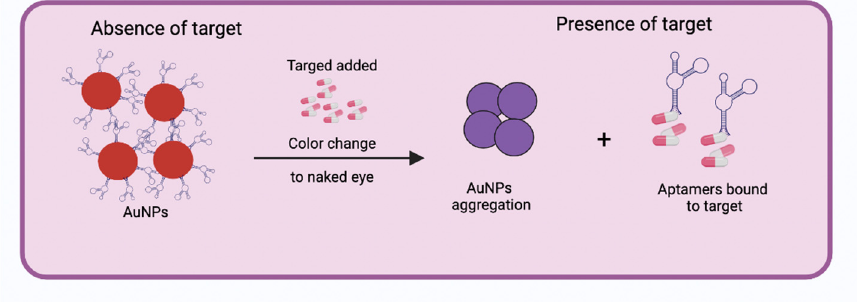
Figure 2. Schematic representation showing the operation of an aptasensor. The soil or water samples are loaded onto the surface of the device, in which the aptamers are immobilized. After the aptamers bind with their target (heavy metals, drugs, bacteria, viruses, or endocrine-disrupting chemicals), they change their conformation and release signals of chemiluminescence, fluorescence, mass change, and changes in electric charge, among others. Created with BioRender.com.